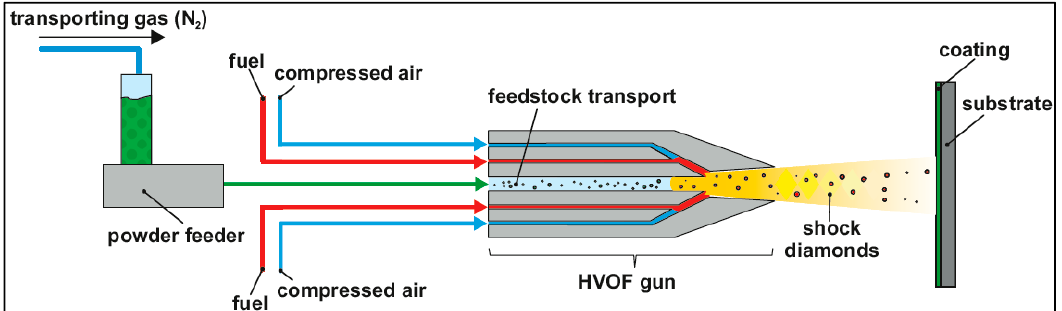
Figure 8. Scheme of high velocity oxy-fuel spraying, inspired by [1]. Reproduced with permission from [Wiley Books], John Wiley and Sons, 2008.